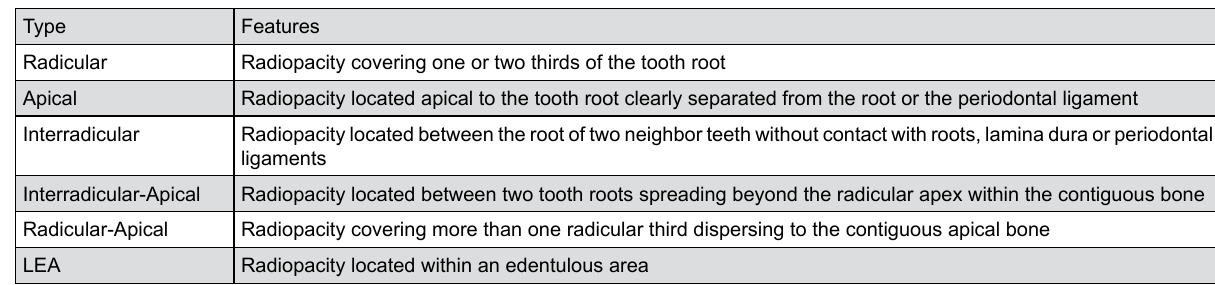
Figure 1- Radiographic types of